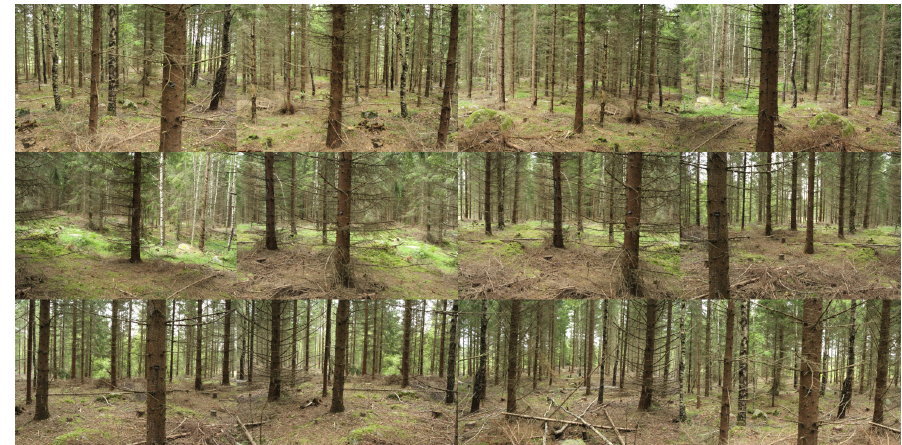
Figure 12. Center camera images from field Plot 203. In contrast to field Plot 165, the images contain a lot of twigs and shrubs on the ground, posing a challenge for the photogrammetric collection of stem